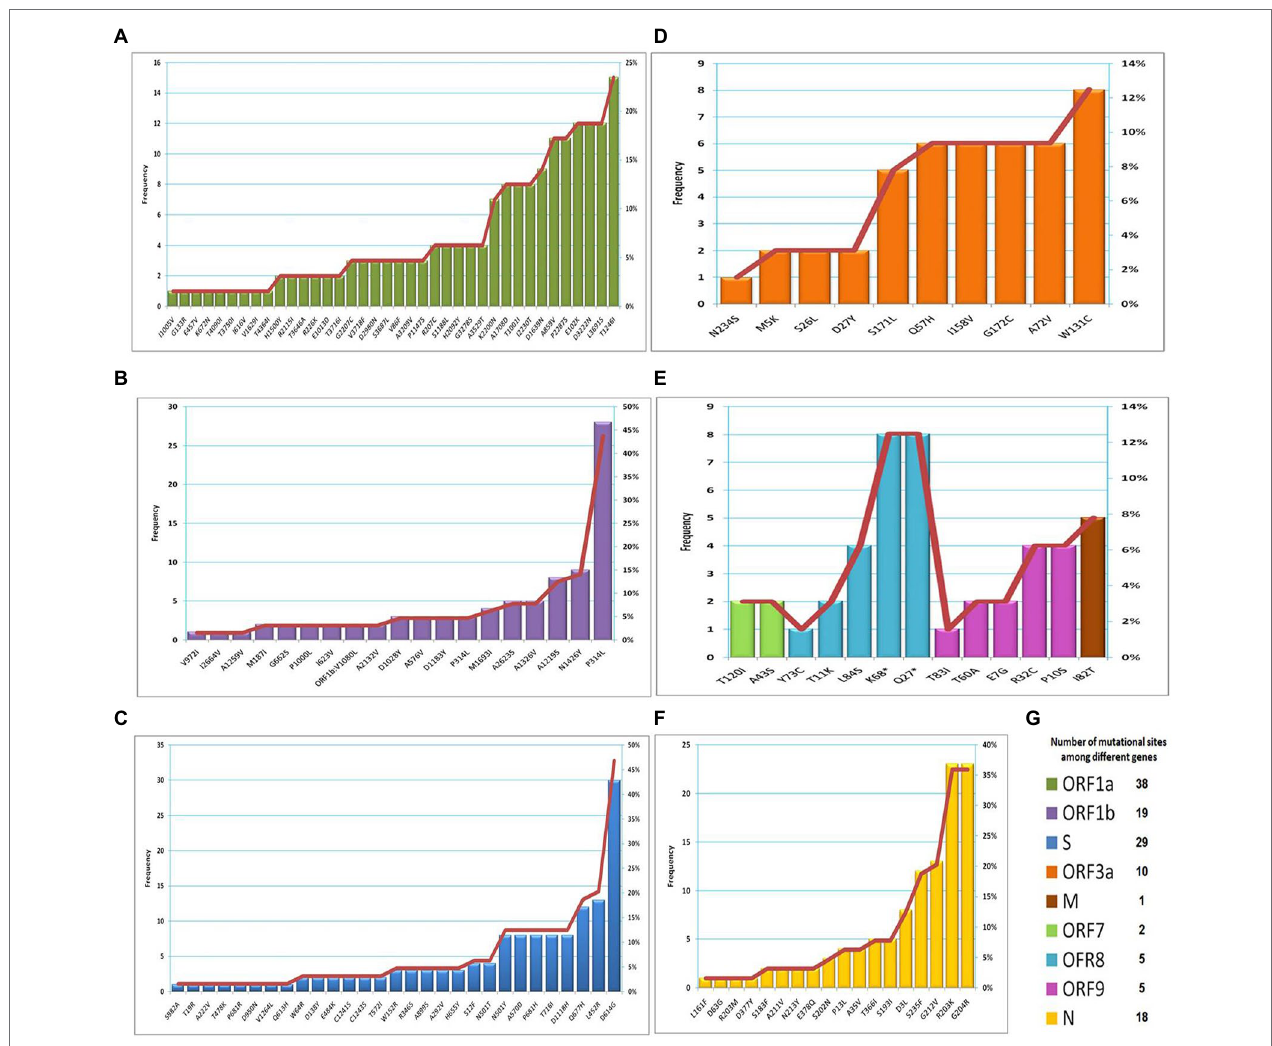
FIGURE 4 | The frequency of mutations observed among different genes. (A) ORF1a; (B) ORF1b; (C) S; (D) ORF3a; (E) M, ORF7, ORF8 and ORF9; (F) N; (G) number of mutational sites distributed among